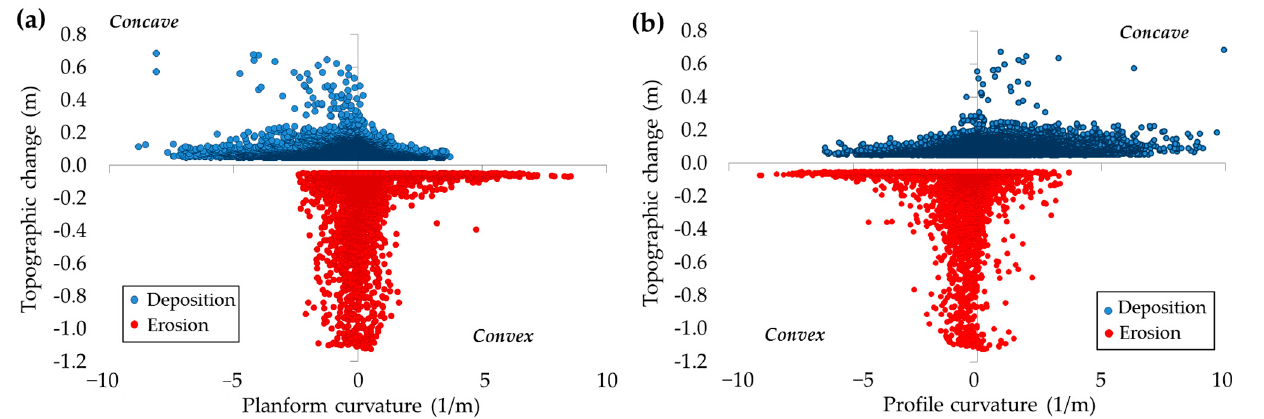
Figure 13. ( a ) Gully planform curvature and ( b ) profile curvature derived from 2016 digital elevation model (DEM) and compared to erosion (red) and deposition (blue) for the whole channel during the period 2016–2019.